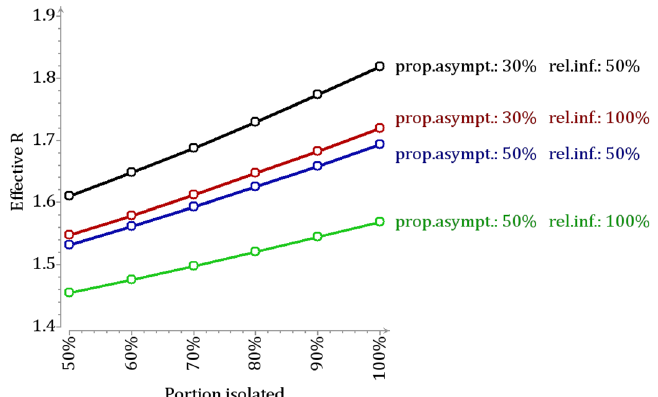
Figure 5. Effective R in the absence of case isolation and quarantine. The figure shows the counterfactual effective reproduction number R c under different assumptions about the coverage of case isolation (i.e. the proportion of all infected that were isolated; horizontal axis), the proportion of asymptomatic infections and the relative infectiousness of asymptomatically infected. The coverage of quarantine, i.e. the proportion of all exposed that were quarantined was assumed to be 33 % .